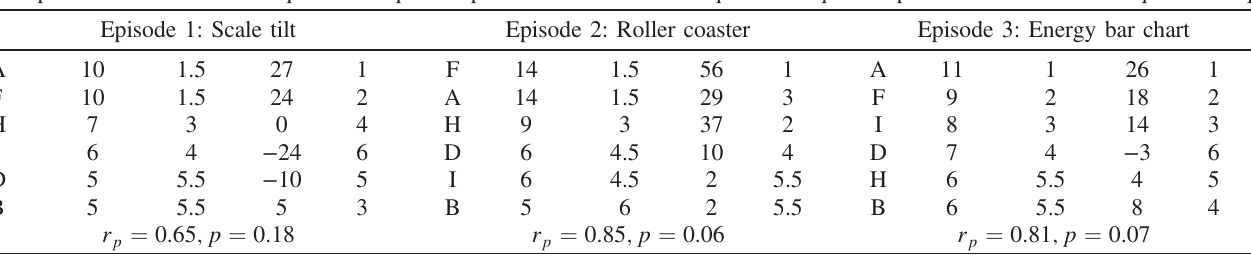
TABLE VI. Effectiveness versus equality score for the top 6 most talkative groups for all three episodes. Probability that each of these correlations happened by random chance ( p ) was calculated using a nondirectional permutation test to create a sampling distribution of r ’